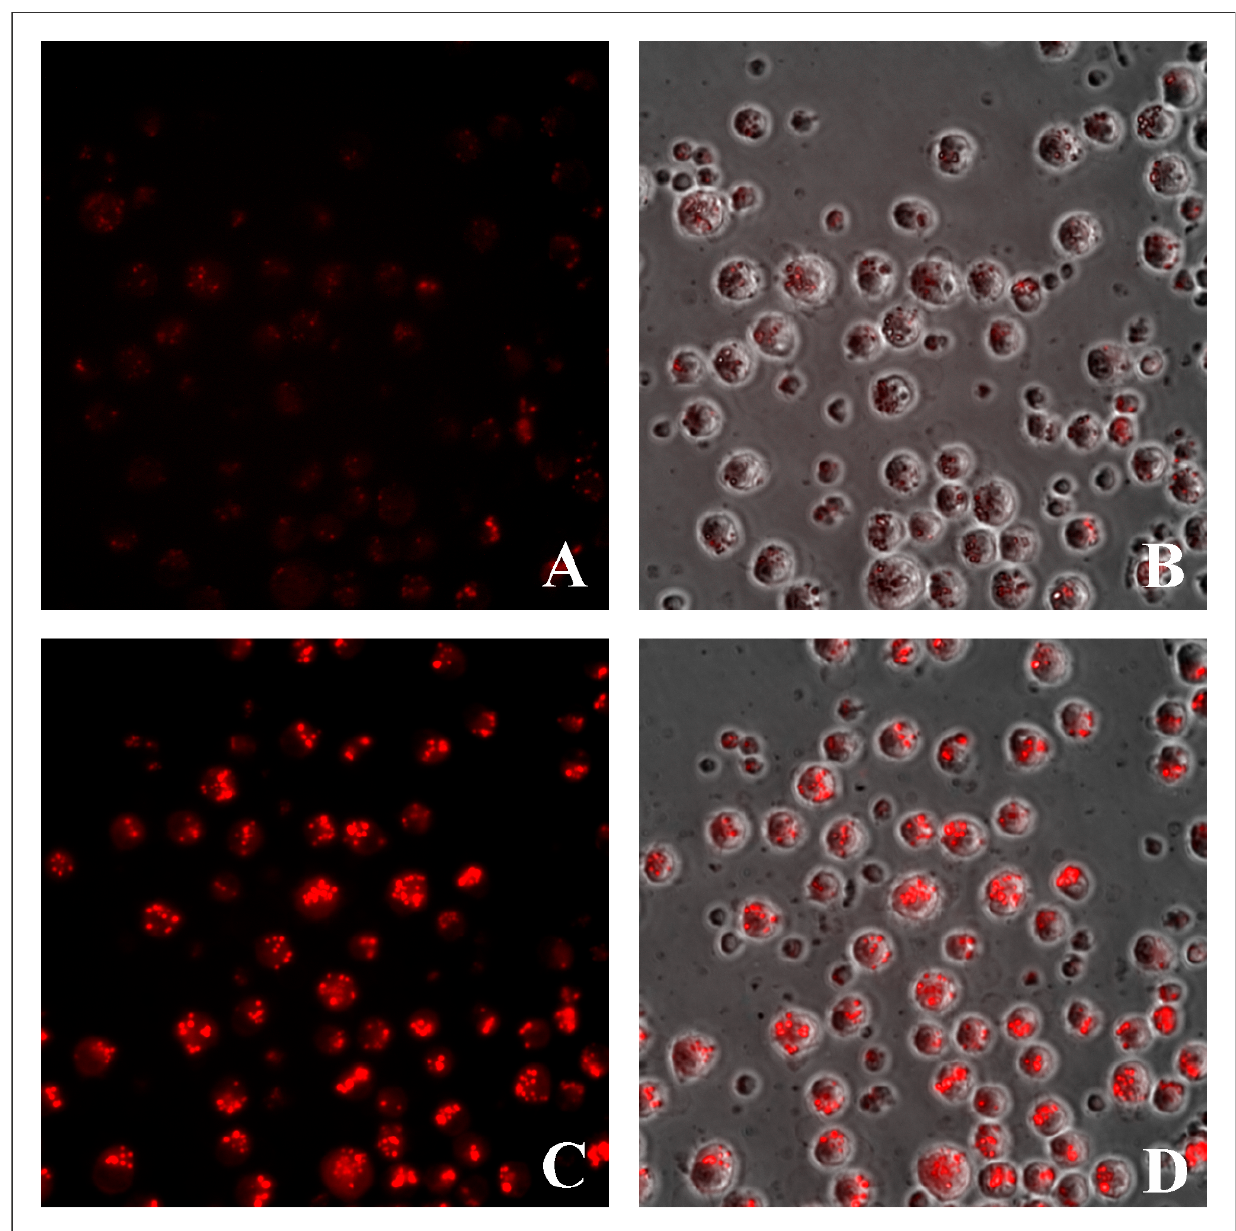
Figure 6. Ehrlich ascites carcinoma cell culture after 1.5 h ( A , B ) and 24 h ( C , D ) of incubation with BODIPY 1 at a concentration of 5 μ M. ( A , C )—fluorescent staining, ( B , D )—overlapping a fluores- cent staining with the phase contrast image. Magnification 40×.